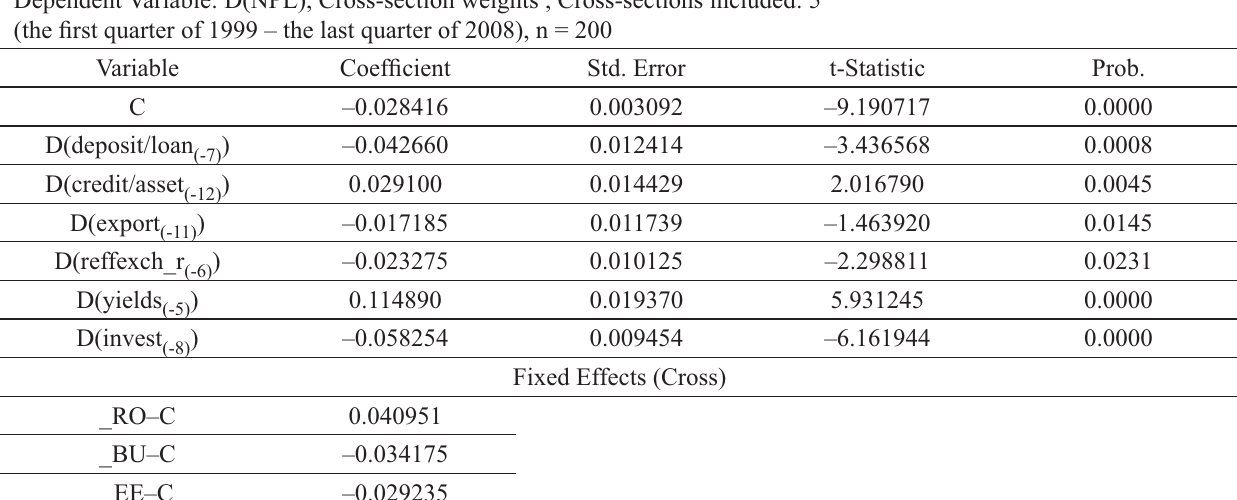
Table 2. The panel regression results for the Baltic States, Bulgaria and Romania Dependent Variable: D(NPL), Cross-section weights , Cross-sections included: